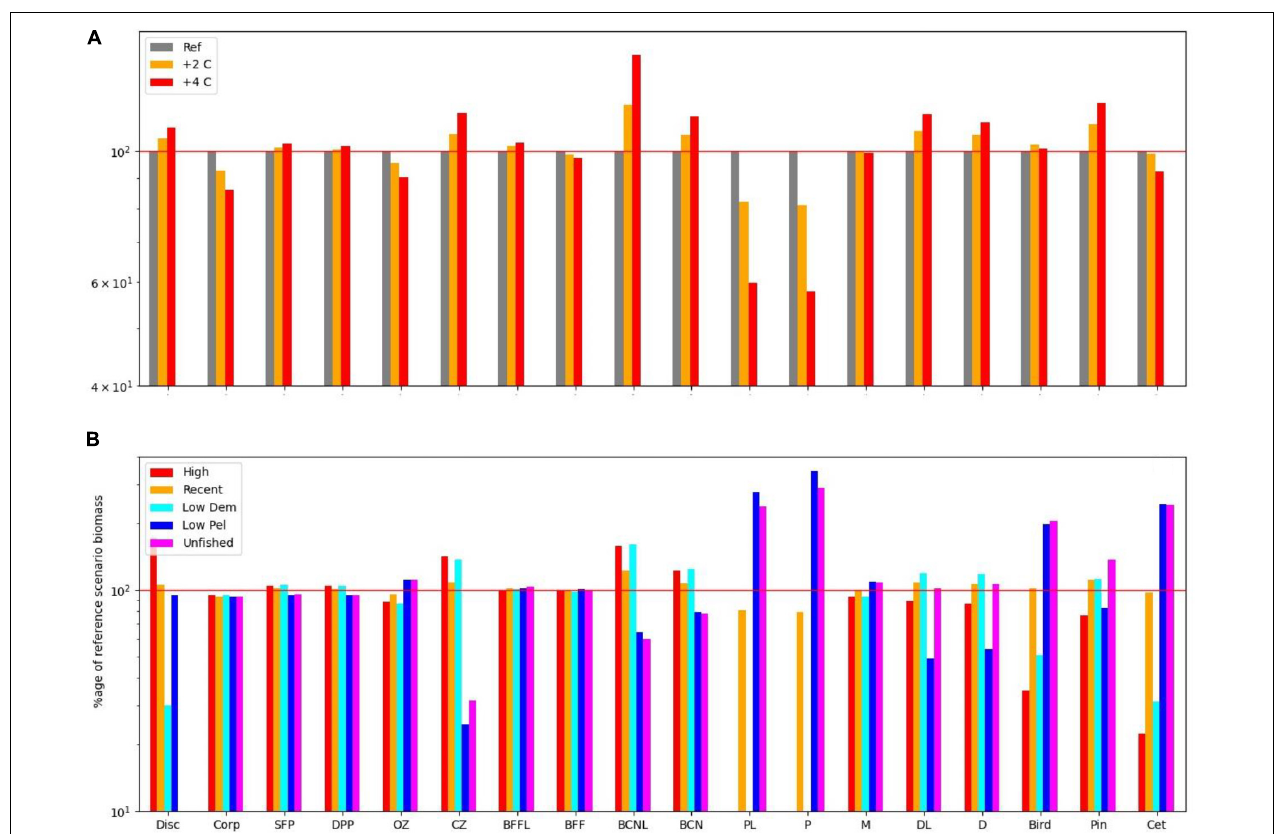
FIGURE 2 | (A) Impact on functional groups across all fishing scenarios for the reference climate, and for warming of 2 and 4 centigrade. (B) Impact on functional groups across all climate, and benthic fishing scenarios for (i) high demersal and pelagic effort, (ii) medium demersal and pelagic effort, (iii) low pelagic effort, (iv) low demersal but high pelagic effort, and (v) low demersal and pelagic effort. Disc, discards; Corp, corpses; SFP, surface phytoplankton; DPP, deep phytoplankton; OZ, omnivorous zooplankton; CZ, carnivorous zooplankton; P, pelagic fish; PL, pelagic larvae; D, demersal fish; DL, demersal larvae; BFFL, benthic filter feeder larvae; BFF, benthic filter feeders; BCNL, benthic carnivore larvae; BCN, benthic carnivores; Bird, birds; Pin, pinnipeds; Cet,